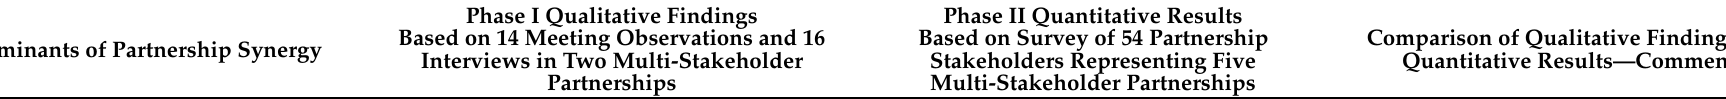
Table 5. Presentation of qualitative, quantitative and comparative results related to partnership assets, enabling processes and partnership synergy.